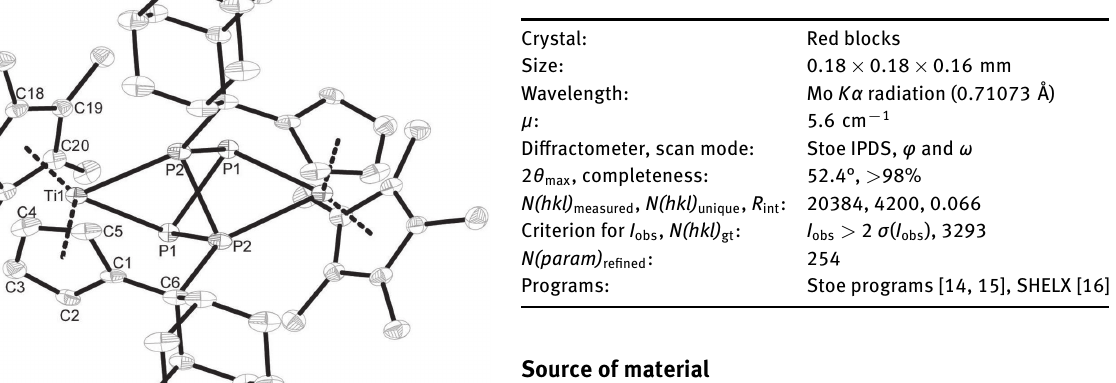
Table 1: Data collection and